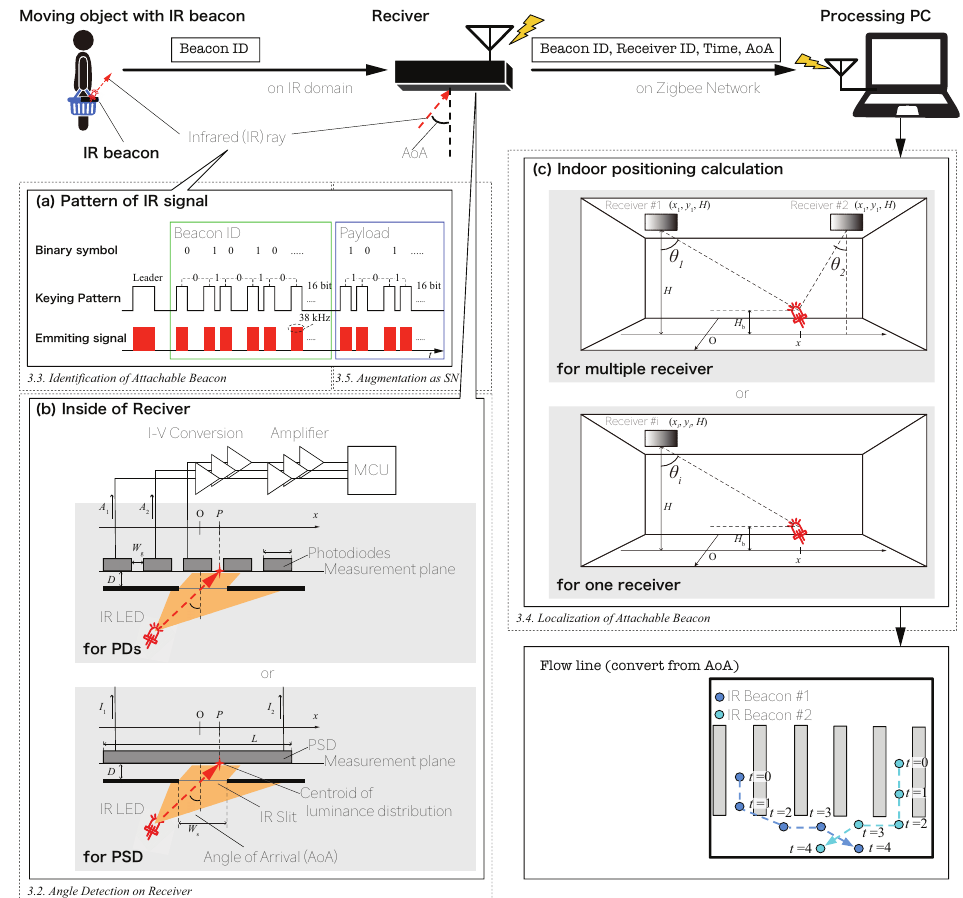
Figure 3. Architecture of the indoor positioning system. This positioning system is composed of beacons, receivers, and the processing PC. The IR beacon sends ID signals and is attached to objects. The receivers are installed on the ceiling. They demodulate the IR signal into information that the processing PC uses to construct the movement map. ( a ) Example of the emission pattern of the IR LED modulated by pulse-width modulation and the method for inserting the payload into the IR signal; ( b ) Mechanism of the slit “spotlights”, a part of the measurement plane; ( c ) Indoor positioning method for performing positioning with multiple angles of arrival, i.e., θ 1 and θ 2 , and when a signal is received by only one receiver. PSD, position-sensitive